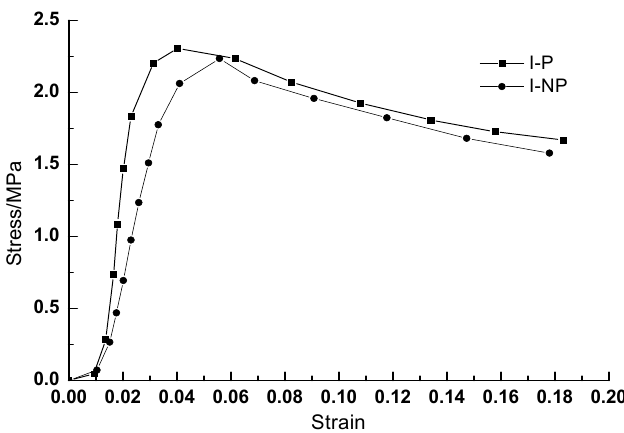
Figure 4. Stress-strain curve of the CA mortar after standard curing for 28 days.